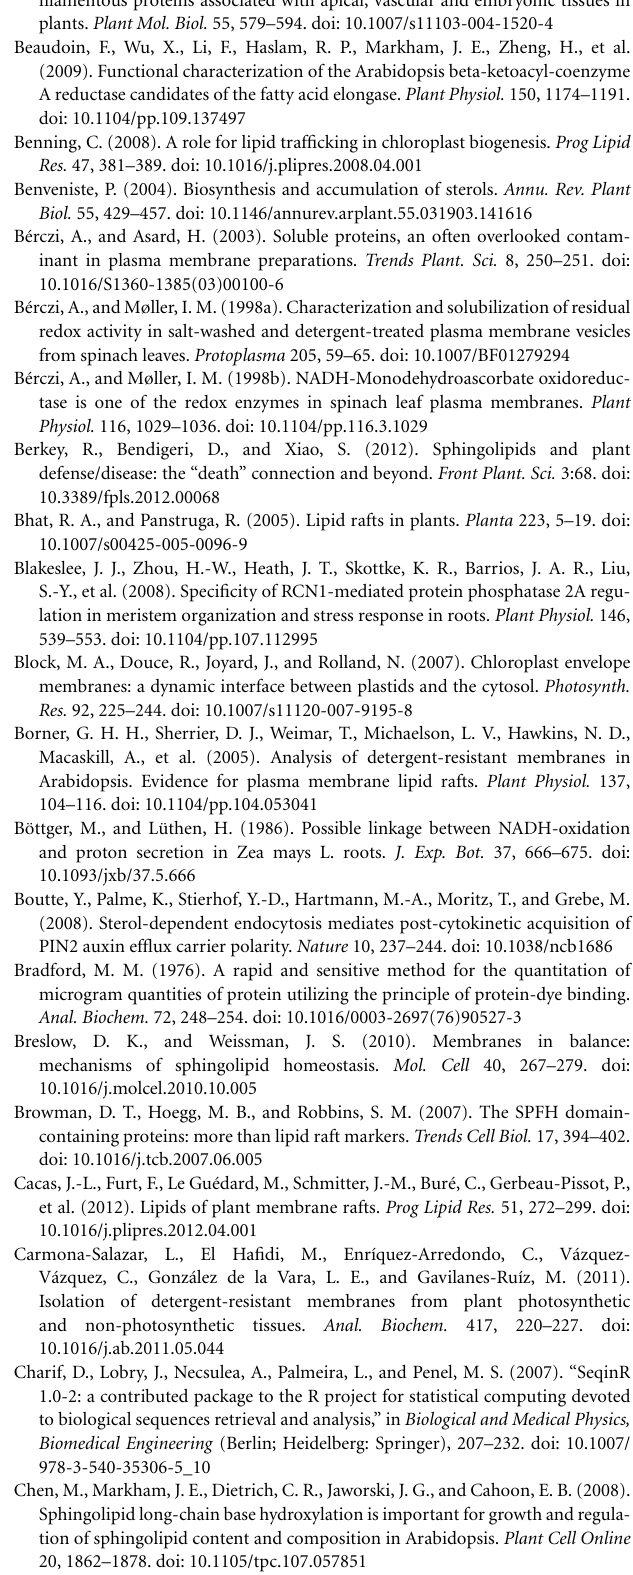
Supplemental Table 1 | List of proteins with significantly different DRM/DSF distributions in mutants versus wildtype. Supplemental Table 2 | List of analyzed lipids. Supplemental Table 3 | List of responding proteins involved in lipid